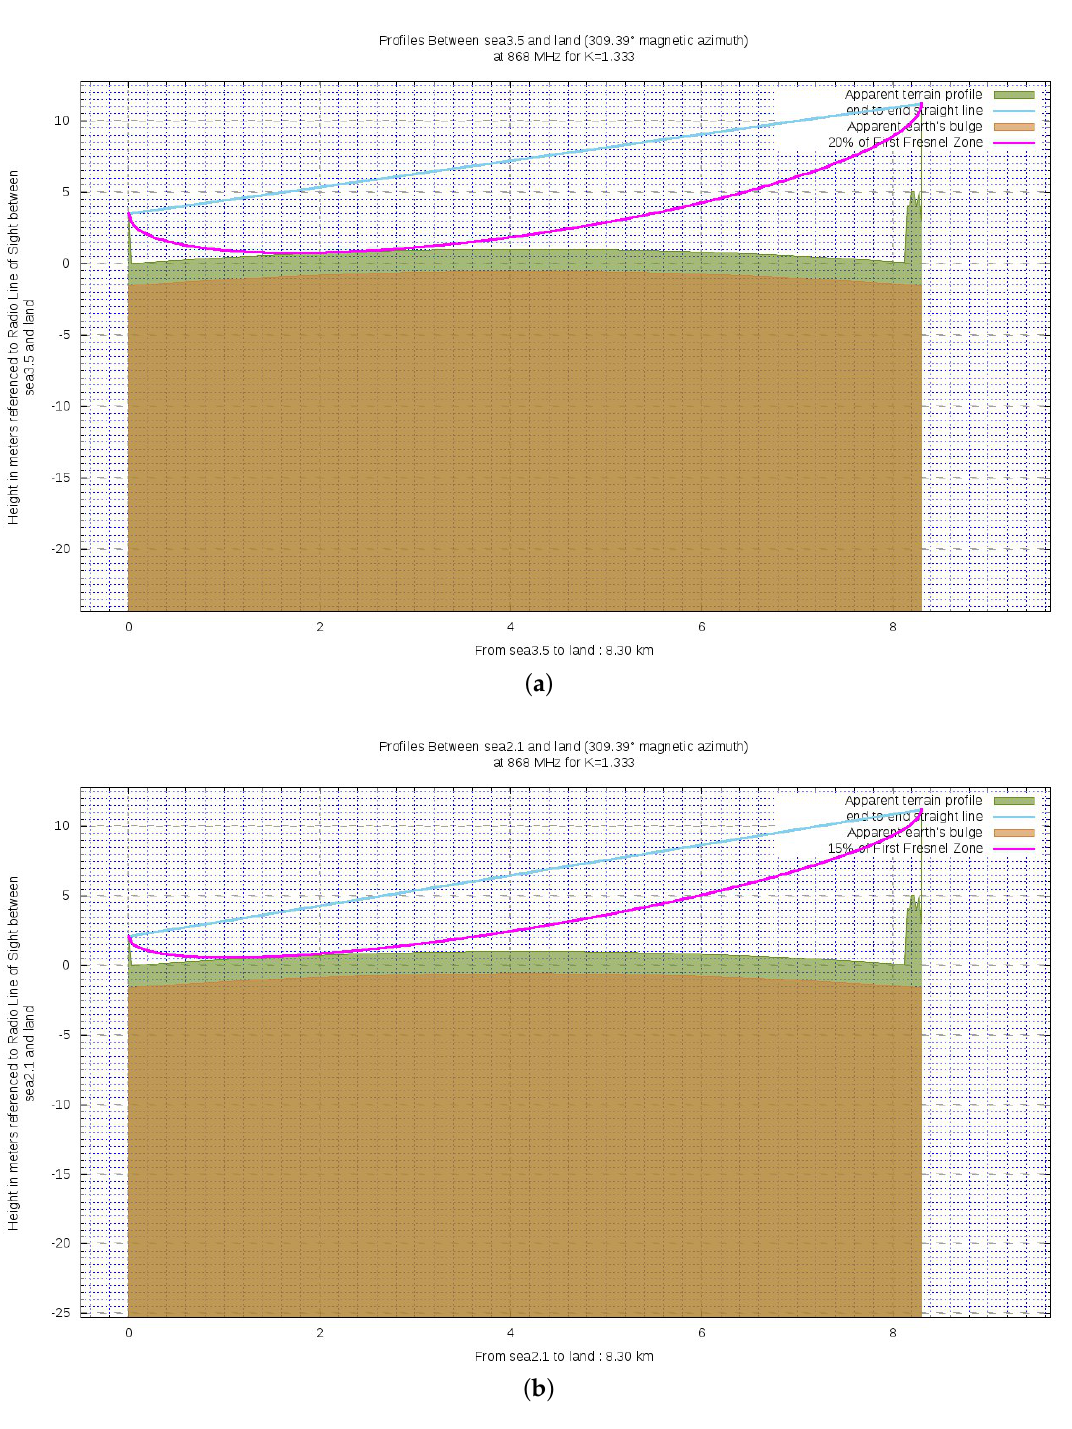
Figure 9. Finer estimates of the actual clearances for both the exploited altitudes for the transmitting = 3.5 m; ( b ) 15% for h = 2.1 antenna: ( a ) 20% for h TX TX 2 1